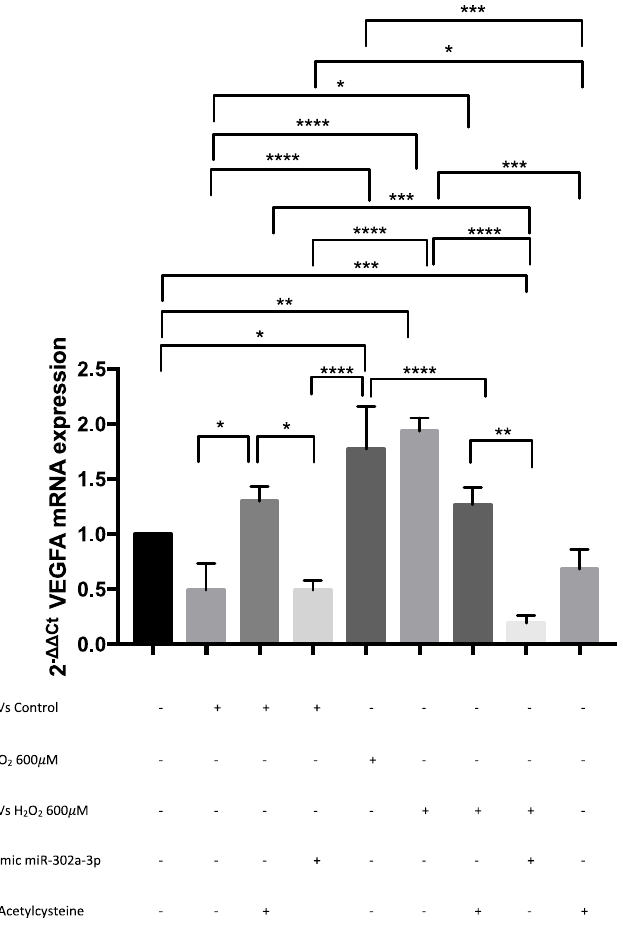
Figure 7. Proangiogenic molecules regulated by miR-302a-3p within sEVs. After 24h of sEV control (0.49 ± 0.24), sEV control and N-acetylcysteine (1.30 ± 0.14), sEV control and miR-302a-3p mimic (0.49 ± 0.09), H 2 O 2 600 µ M (1.77 ± 0.39), sEVs H 2 O 2 600 µ M (1.94 ± 0.12), sEVs H 2 O 2 600 µ M and N-acetylcysteine (1.27 ± 0.16), sEV H 2 O 2 600 µ M and miR-302a-3p mimic (0.19 ± 0.07), and N-acetylcysteine (0.68 ± 0.18) exposure the mRNA VEGFA expression was analyzed by q-RT-PCR. Values are expressed as mean ± SEM ( n = 4–5). The p -value was calculated by ANOVA; * p < 0.05, ** p < 0.01, *** p < 0.001, and **** p < 0.0001.